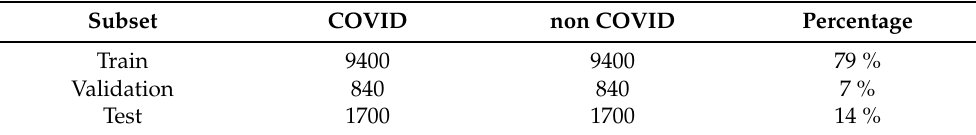
Table 4. The Number of Slices Used for Training, Validation and Test.